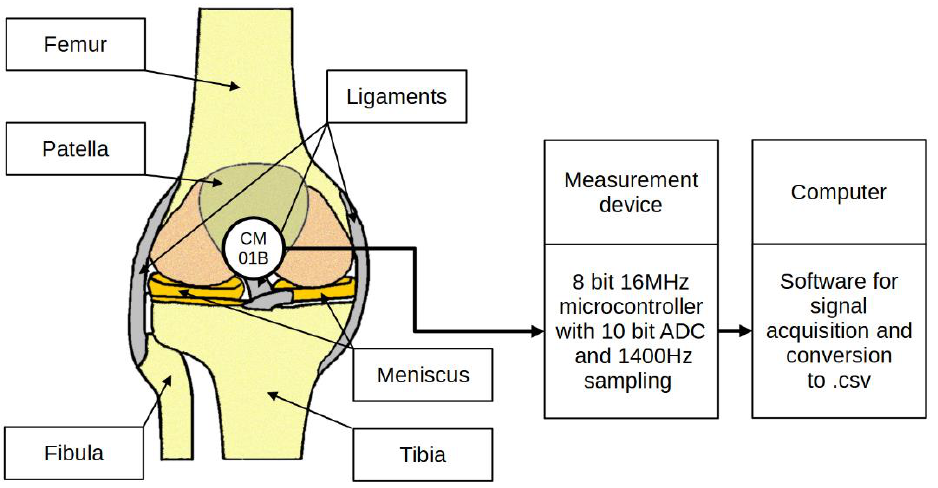
Figure 3. Placement of the sensor and measurement concept. Examples of normalized signals for healthy and injured knees in the time and fre- quency domain for OKC and CKC recorded with a sensor placed on the patella are shown in Figure